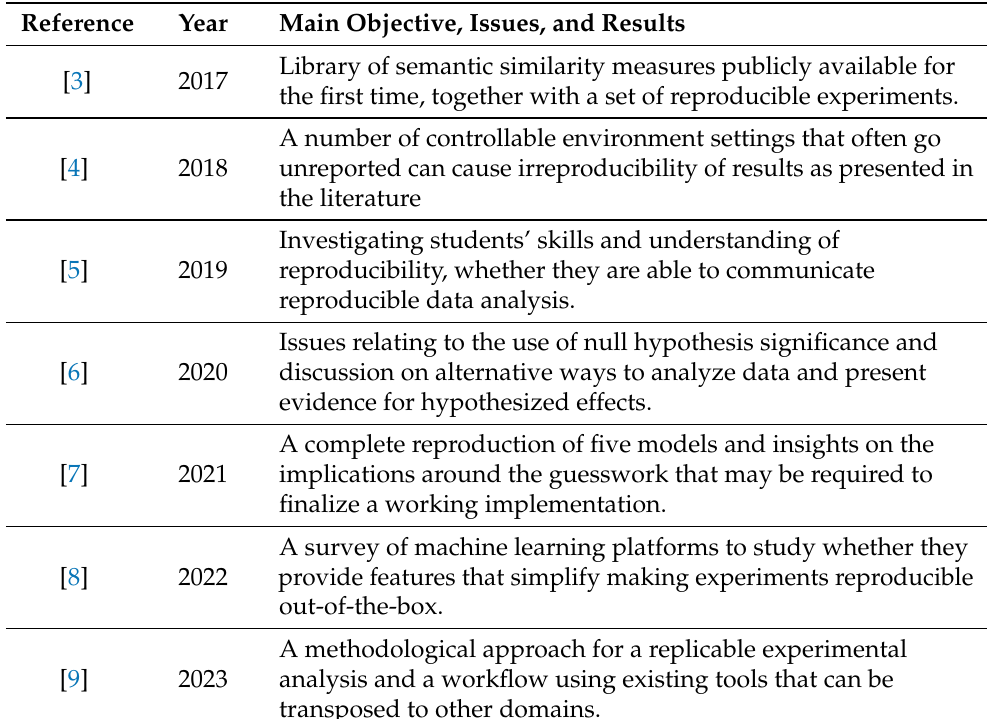
Table 1. Overview of the latest research on reproducibility